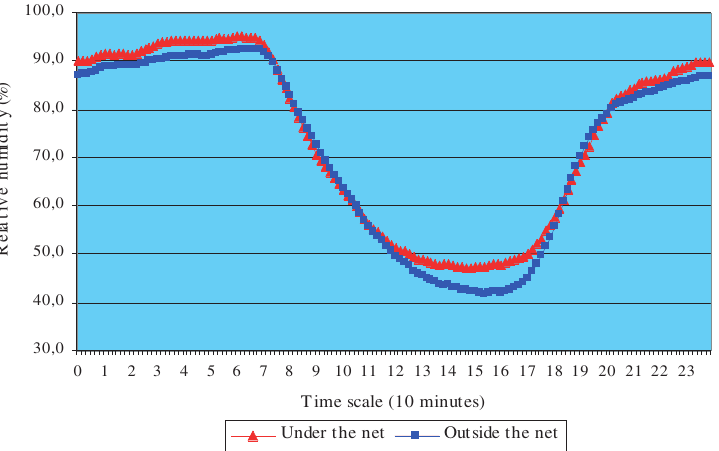
<10°C )/Pallag 2011 June 1 – Table 3. The statistical parameters of daily amplitude of diff global radiation measured under the hail protection net and outside of it /Pallag 2011 June 1 – September